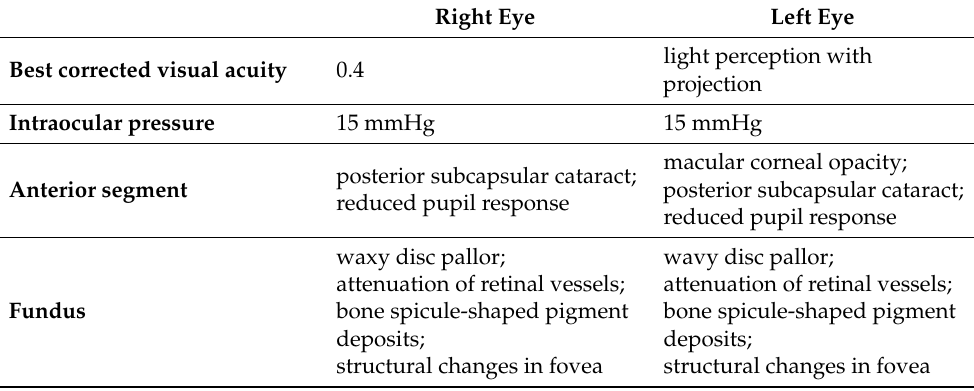
Table 1. Ophthalmological clinical findings.